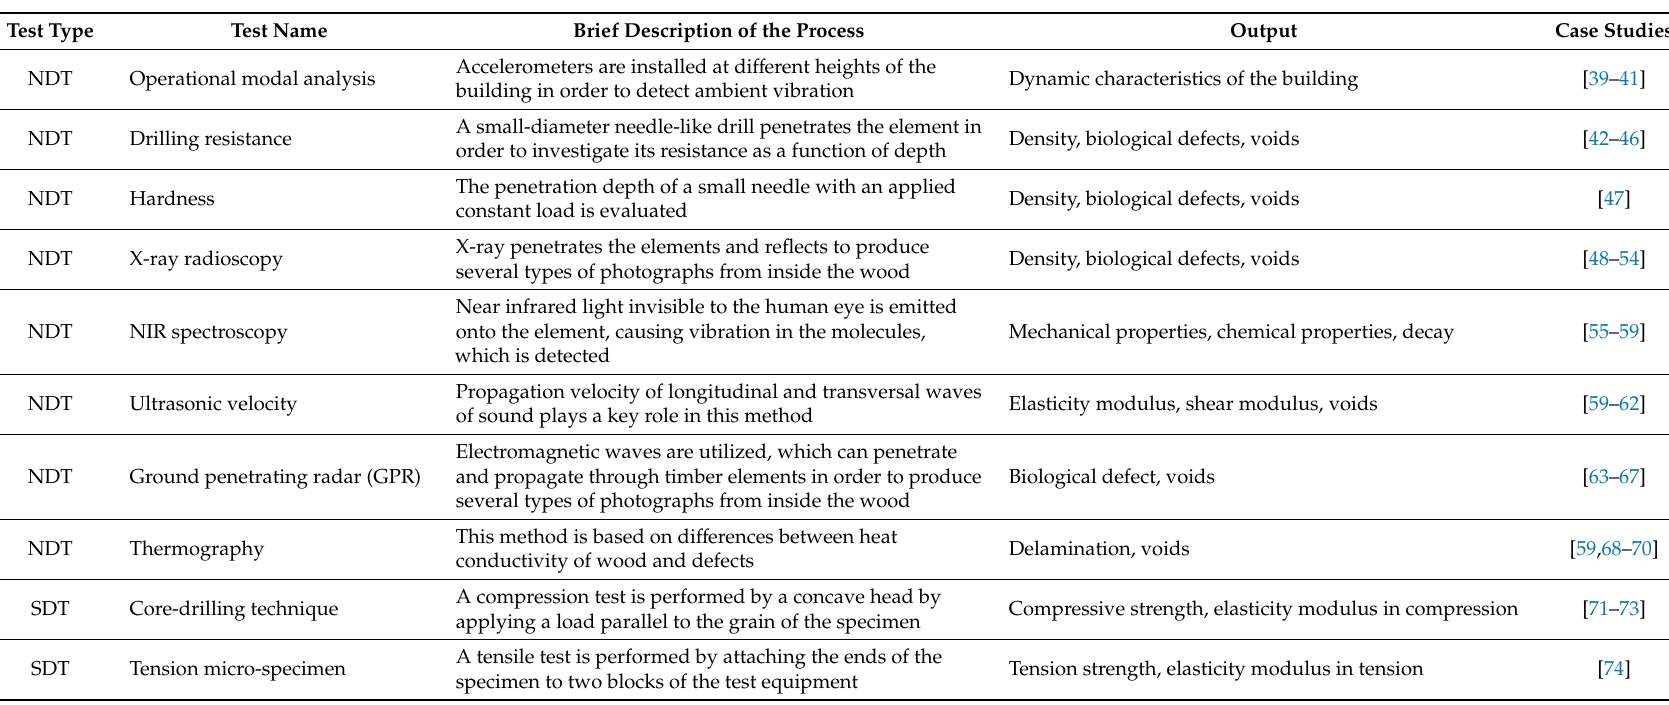
Table 1. Non-destructive test (NDT) / semi-destructive test (SDT) applicable for in situ assessment of heritage timber buildings with the outcome of each test and relevant case